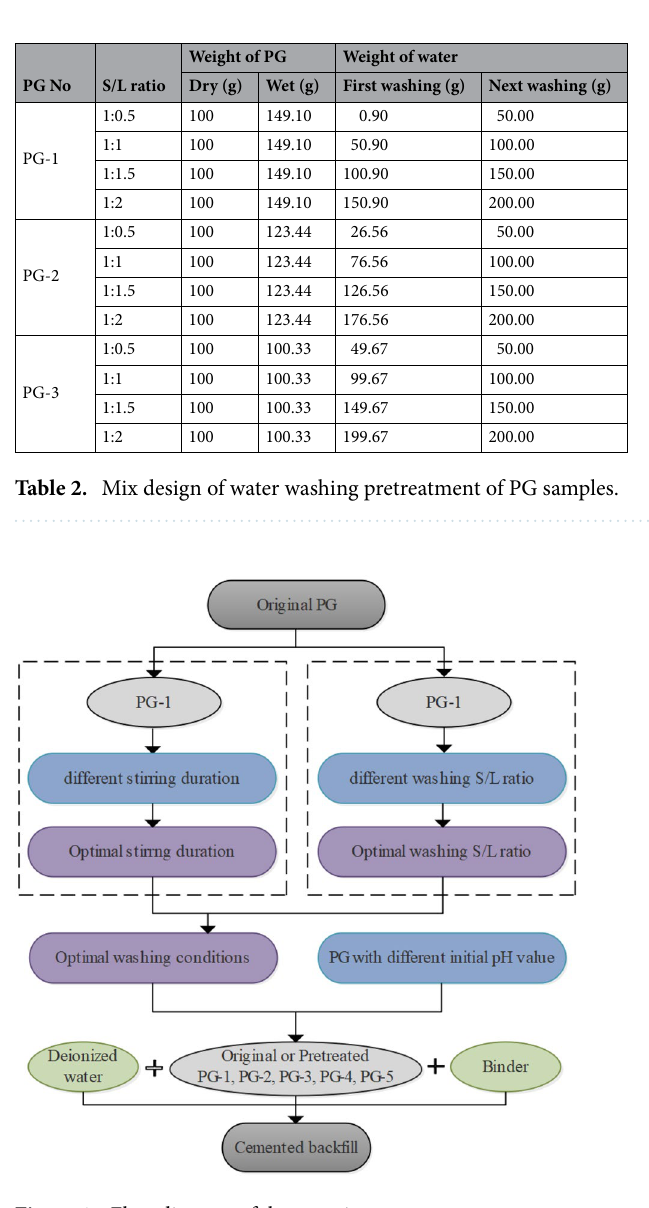
Figure 1. Flow diagram of the